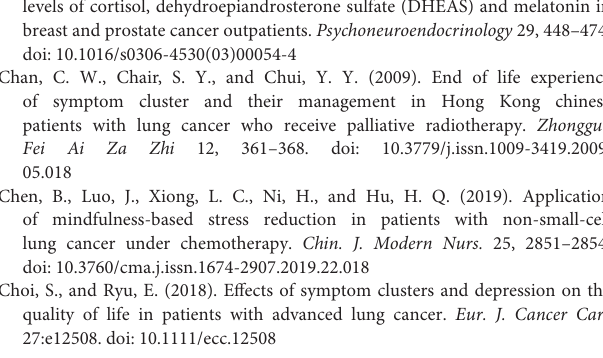
Supplementary Table 1 | Search strategies of targeted English